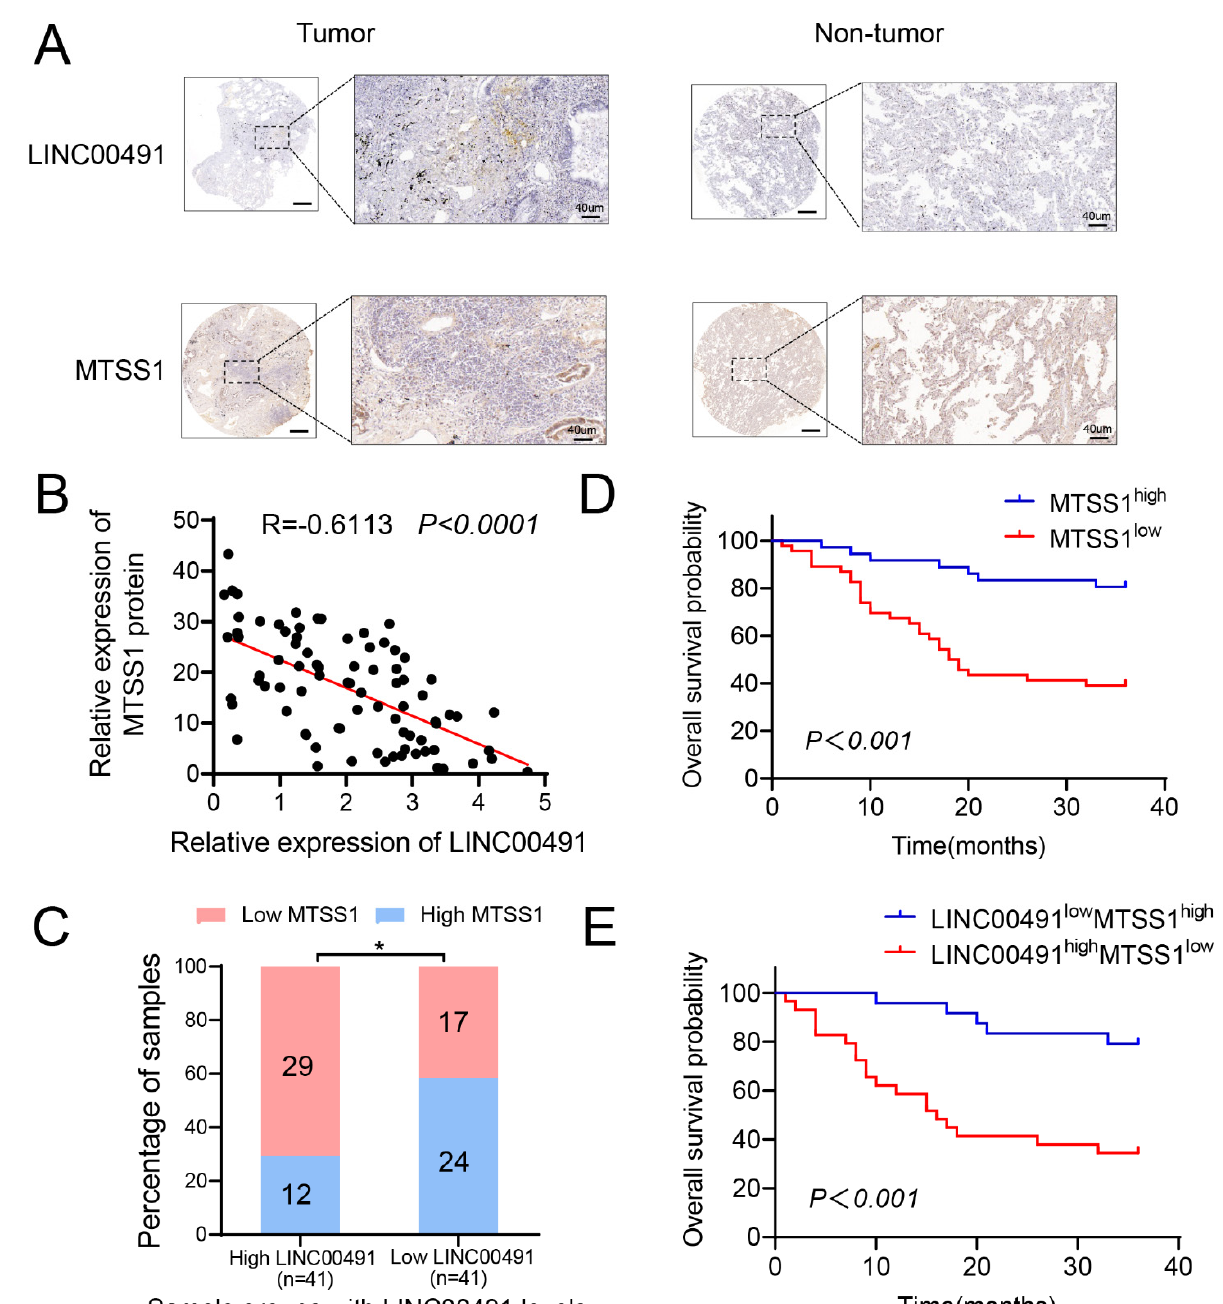
Figure 6. LINC00491 and MTSS1 were associated with the prognosis of LUAD patients. ( A ) Repre- sentative images of ISH and IHC assay showed LINC00491 and MTSS1 expression in LUAD and matched normal lung tissues. Scale bars = 200 µ m and 40 µ m. ( B ) Correlation between LINC00491 and MTSS1 protein expression in LUAD patients. ( C ) Positive correlation of LINC00491 with MTSS1 protein levels. The 82 samples were classified into two groups (Low USP32: 41; High USP32: 41). ( D ) The log-rank test of the impact of the MTSS1 protein level on the survival of patients with LUAD. ( E ) Retrospective analysis of Kaplan–Meier plots for LINC00491 and MTSS1 expression in association with overall survival time. Data are presented as the mean ± SD. *, p < 0.05.